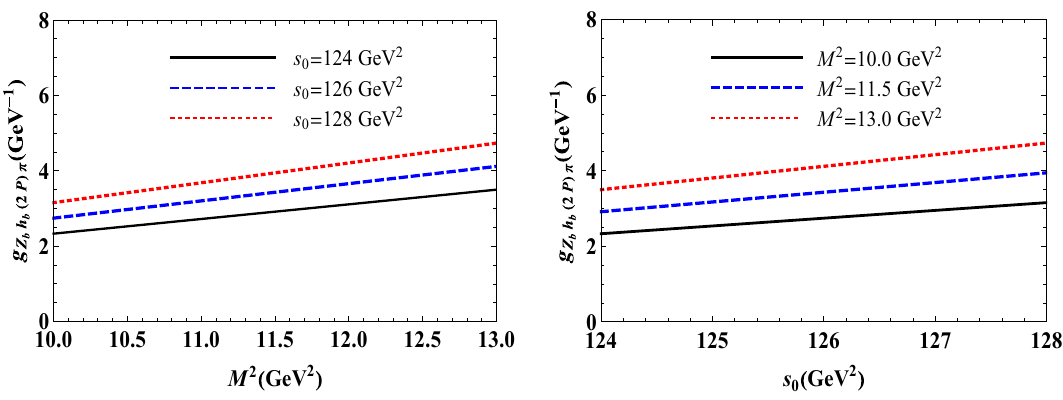
Fig. 5 The coupling g Z